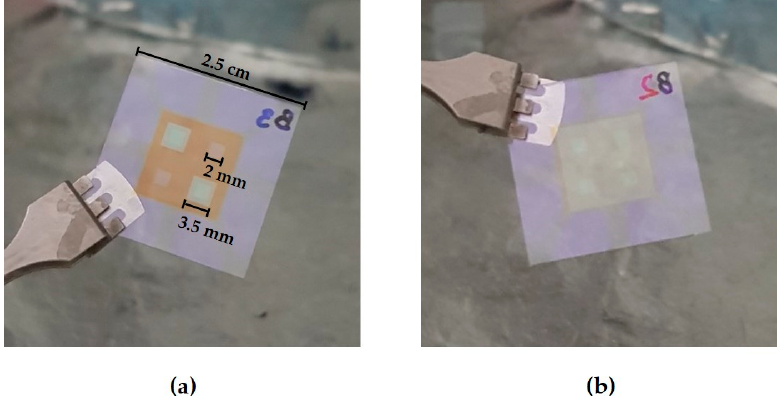
Figure 3. Photographic images of ( a ) the patterned device substrate after photoresist (PR) development and ( b ) the reference device substrate.